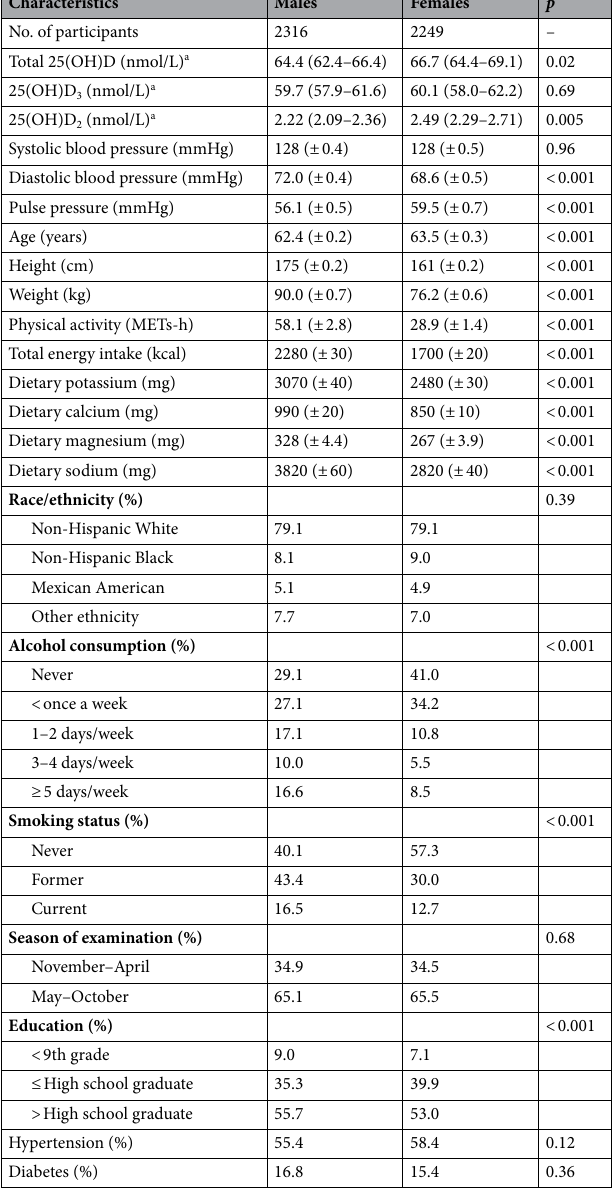
Table 1. Participants characteristics by sex. Survey t-test for continuous variables and survey (Rao-Scott) χ 2 test for categorical variables were used. a Geometric mean (95% confidence intervals) are